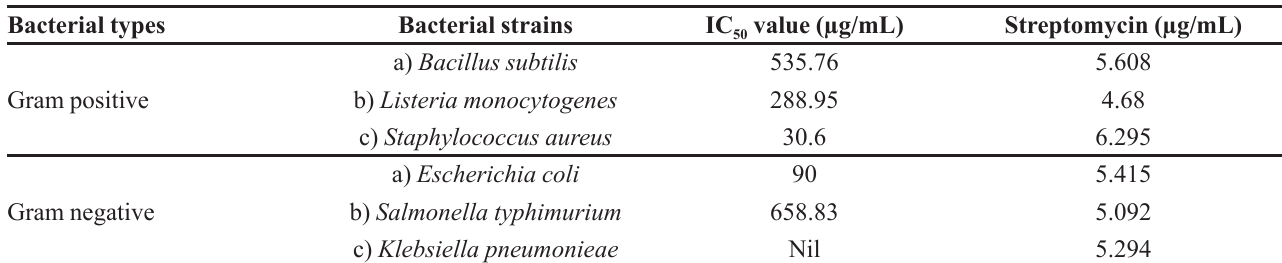
TABLE II - Antimicrobial activity of methanolic fraction extracted from Lepista sordida . Results are represented as IC (mean ± standard deviation; n = 3) Bacterial